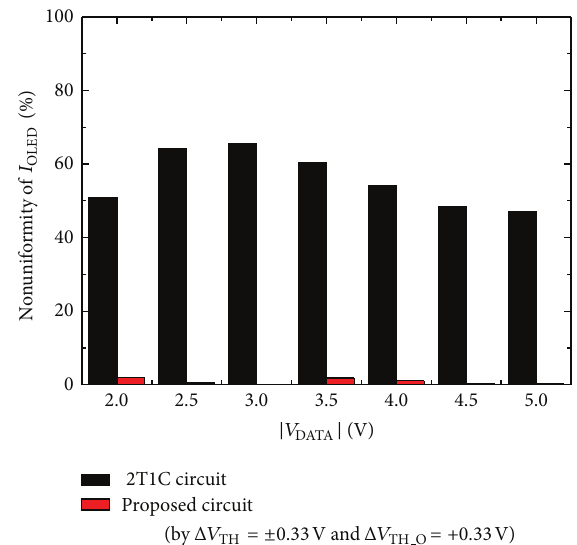
Figure 6: The error rates of 𝐼 voltage variations ( Δ𝑉 rate is 0.5%.